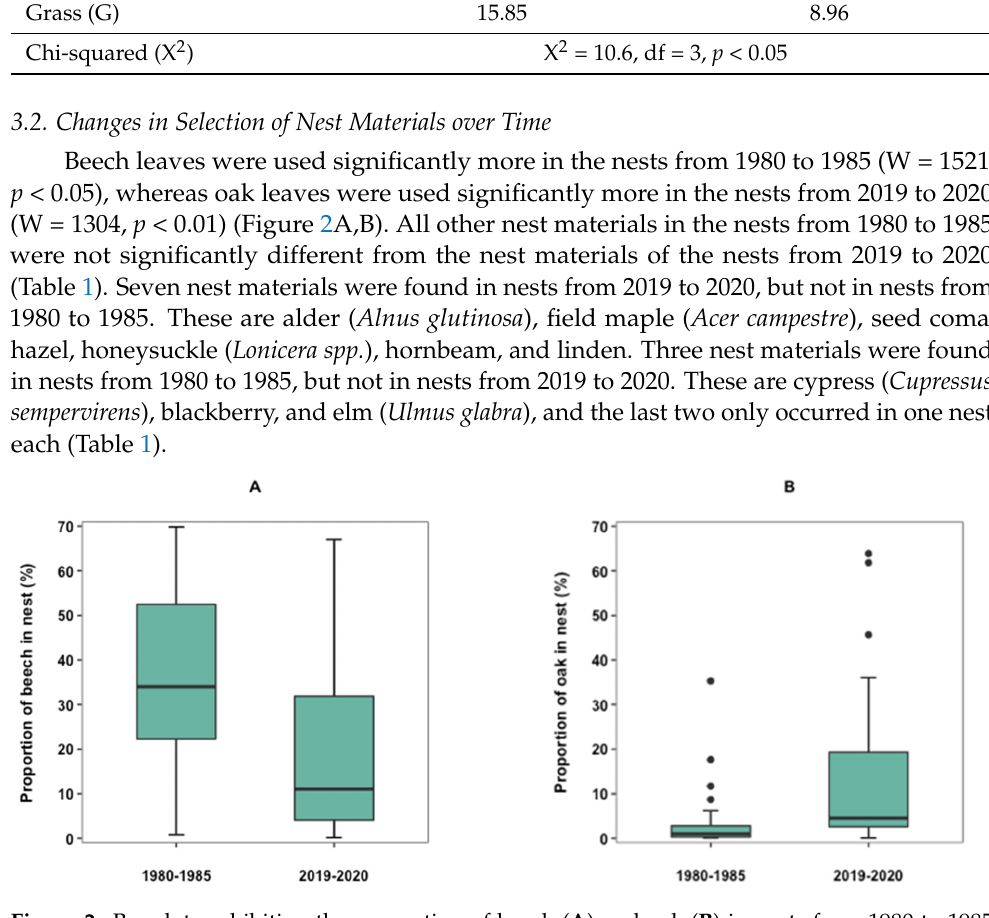
Table 2. Distribution of nest types in the periods 1980–1985 (n = 82) and 2019–2020 (n = 66). The chi-squared test shows a significant difference between selection of nest type in the two periods. Nest Type